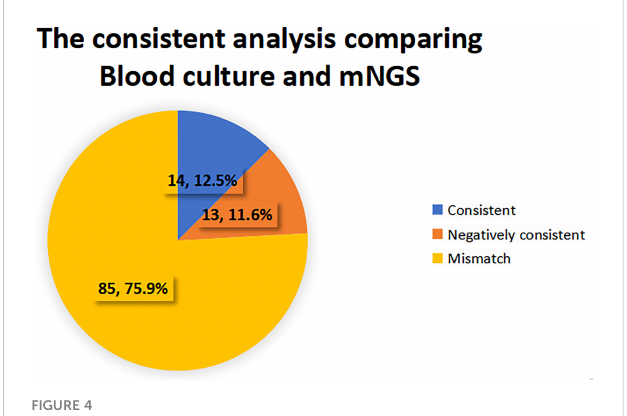
FIGURE 4 Consistency analysis of pathogens detected by blood culture and mNGS.